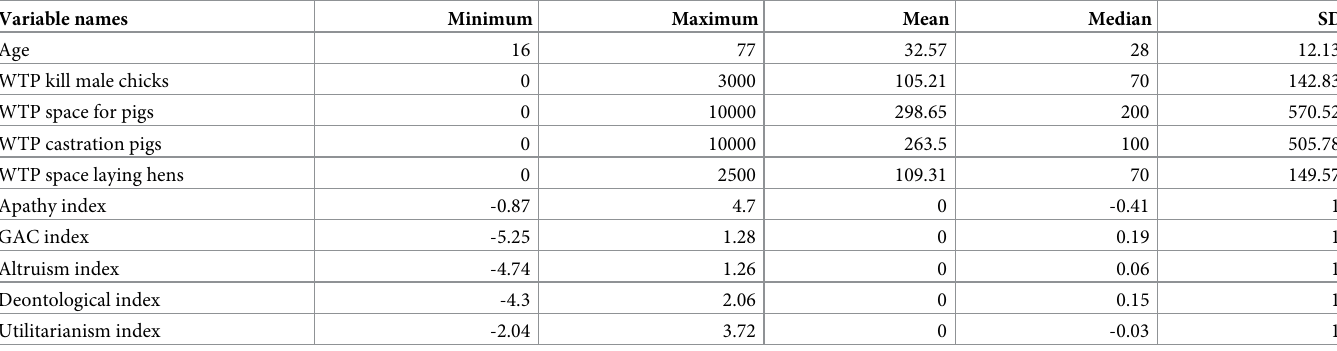
Table 1. Descriptive statistics of key variables in the survey (n =